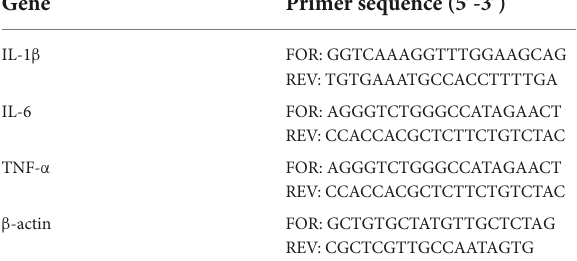
TABLE 1 Primers used in this study.